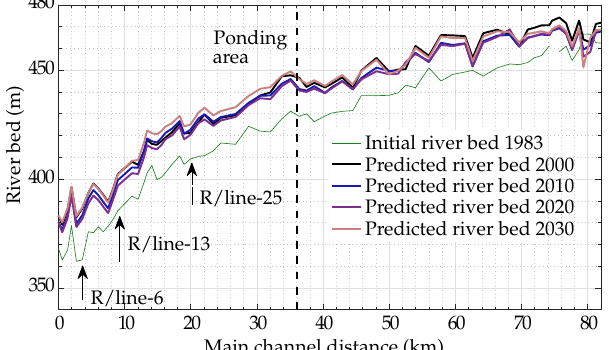
Figure 17. Longitudinal profile of predicted river bed using WA-ANN predicted sediment boundary conditions.